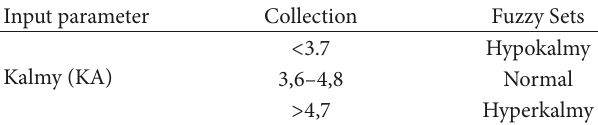
Table 3: The range of Kalmy input parameter.